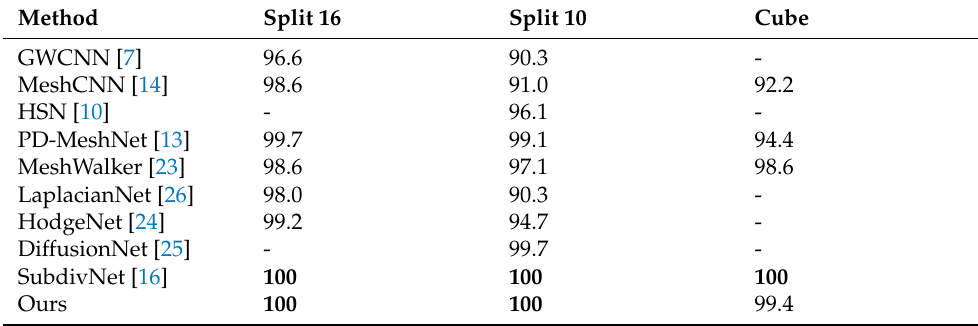
Table 1. Classification results on SHREC11 and Cube engraving.